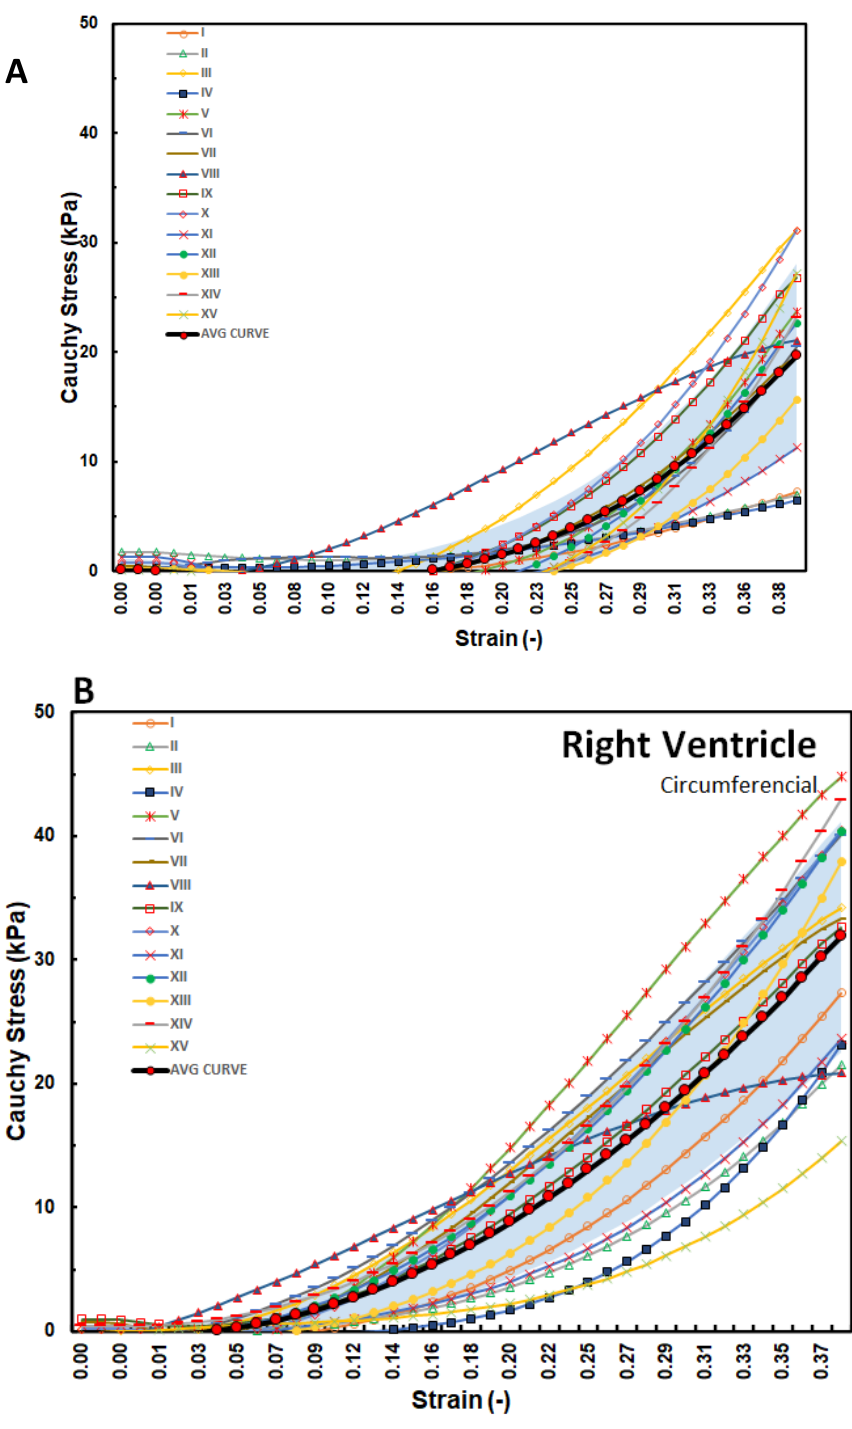
Figure 5. Stress–strain graphs for RV myocardium in the ( A ) longitudinal and ( B ) circumferential directions overlayed with one-standard deviation regions as well as an average curve.